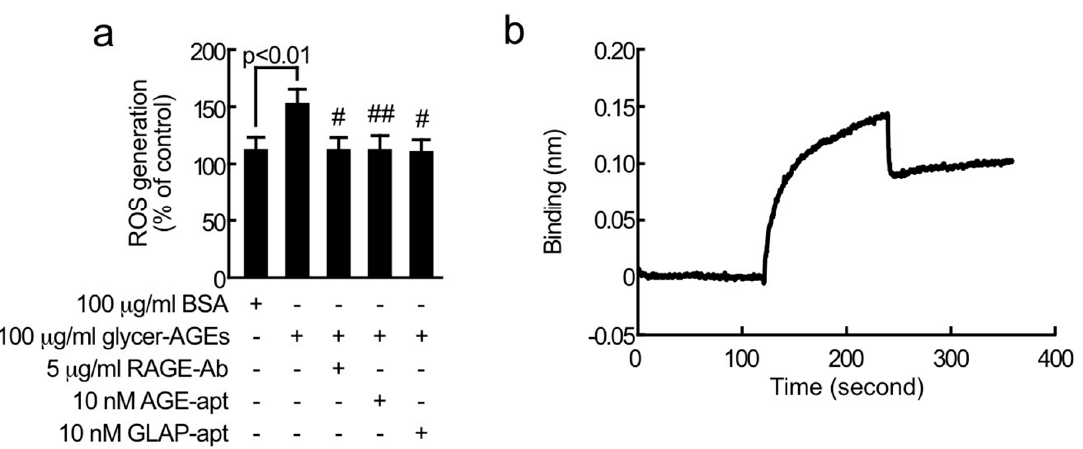
Figure 1. ( a ) Effects of RAGE-Ab, AGE-aptamer (AGE-apt), or GLAP-aptamer (GLAP-apt), on reactive oxygen species (ROS) generation in glycer-AGE-exposed tubular cells. Tubular cells were treated with 100 μ g/mL glycer-AGEs or 100 μ g/mL non-glycated bovine serum albumin (BSA) in the presence or absence of 5 μ g/mL RAGE-Ab, 10 nM AGE-apt, or 10 nM GLAP-apt for 1 h. ROS generation was evaluated by CellRox oxidative stress reagents. N = 6–12 per group. # and ##, p < 0.05 and p < 0.01 compared to the values with 100 μ g/mL glycer-AGEs. ( b ) The interaction of GLAP-aptamer to immobilized glycer-AGEs was analyzed by bio-layer interferometry. N = 4 per group.